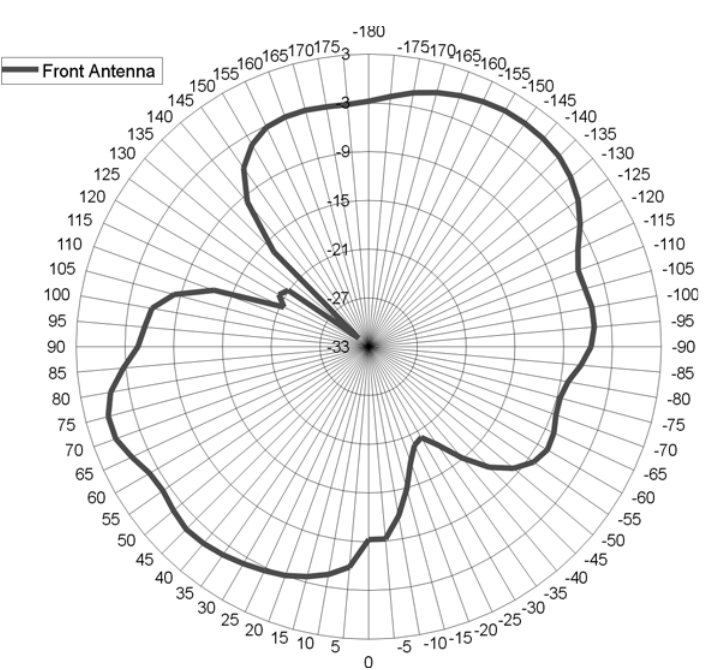
FIGURE 12 Azimuthal pattern of a realised